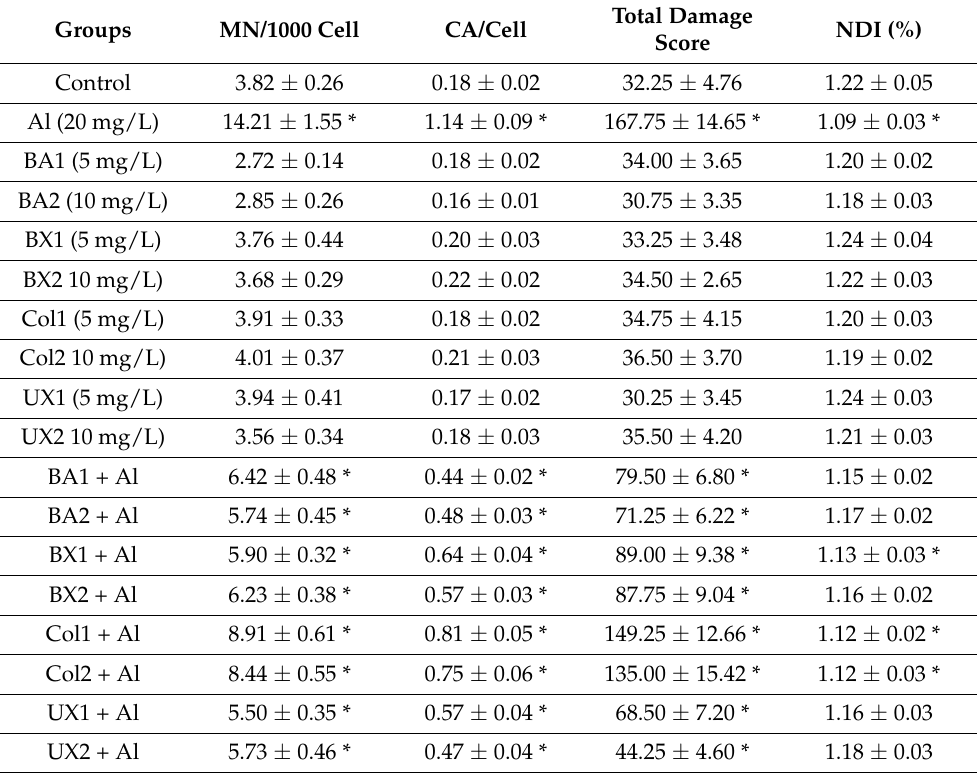
Table 3. The genotoxicity of boron compounds and Al on the CA, MN, SCGE and NDI rates in peripheric human blood